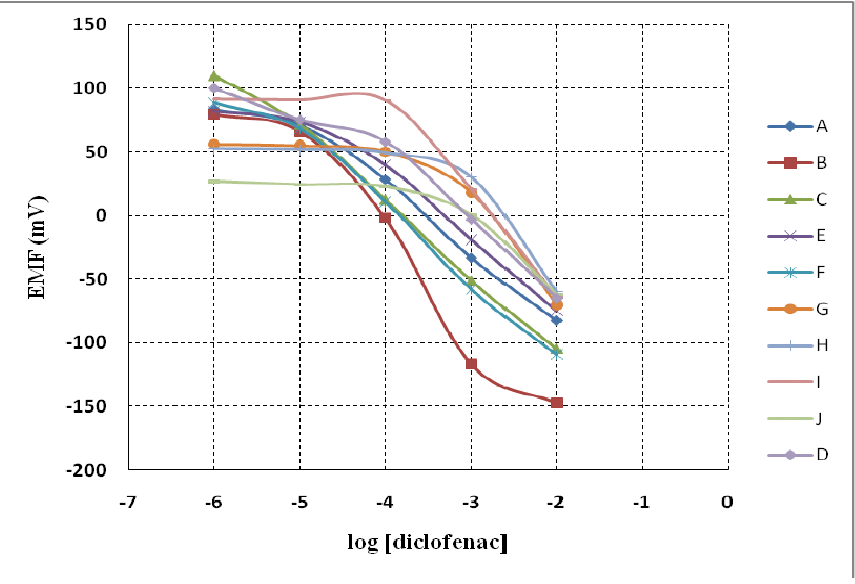
Figure 3. Potentiometric response to diclofenac of the obtained